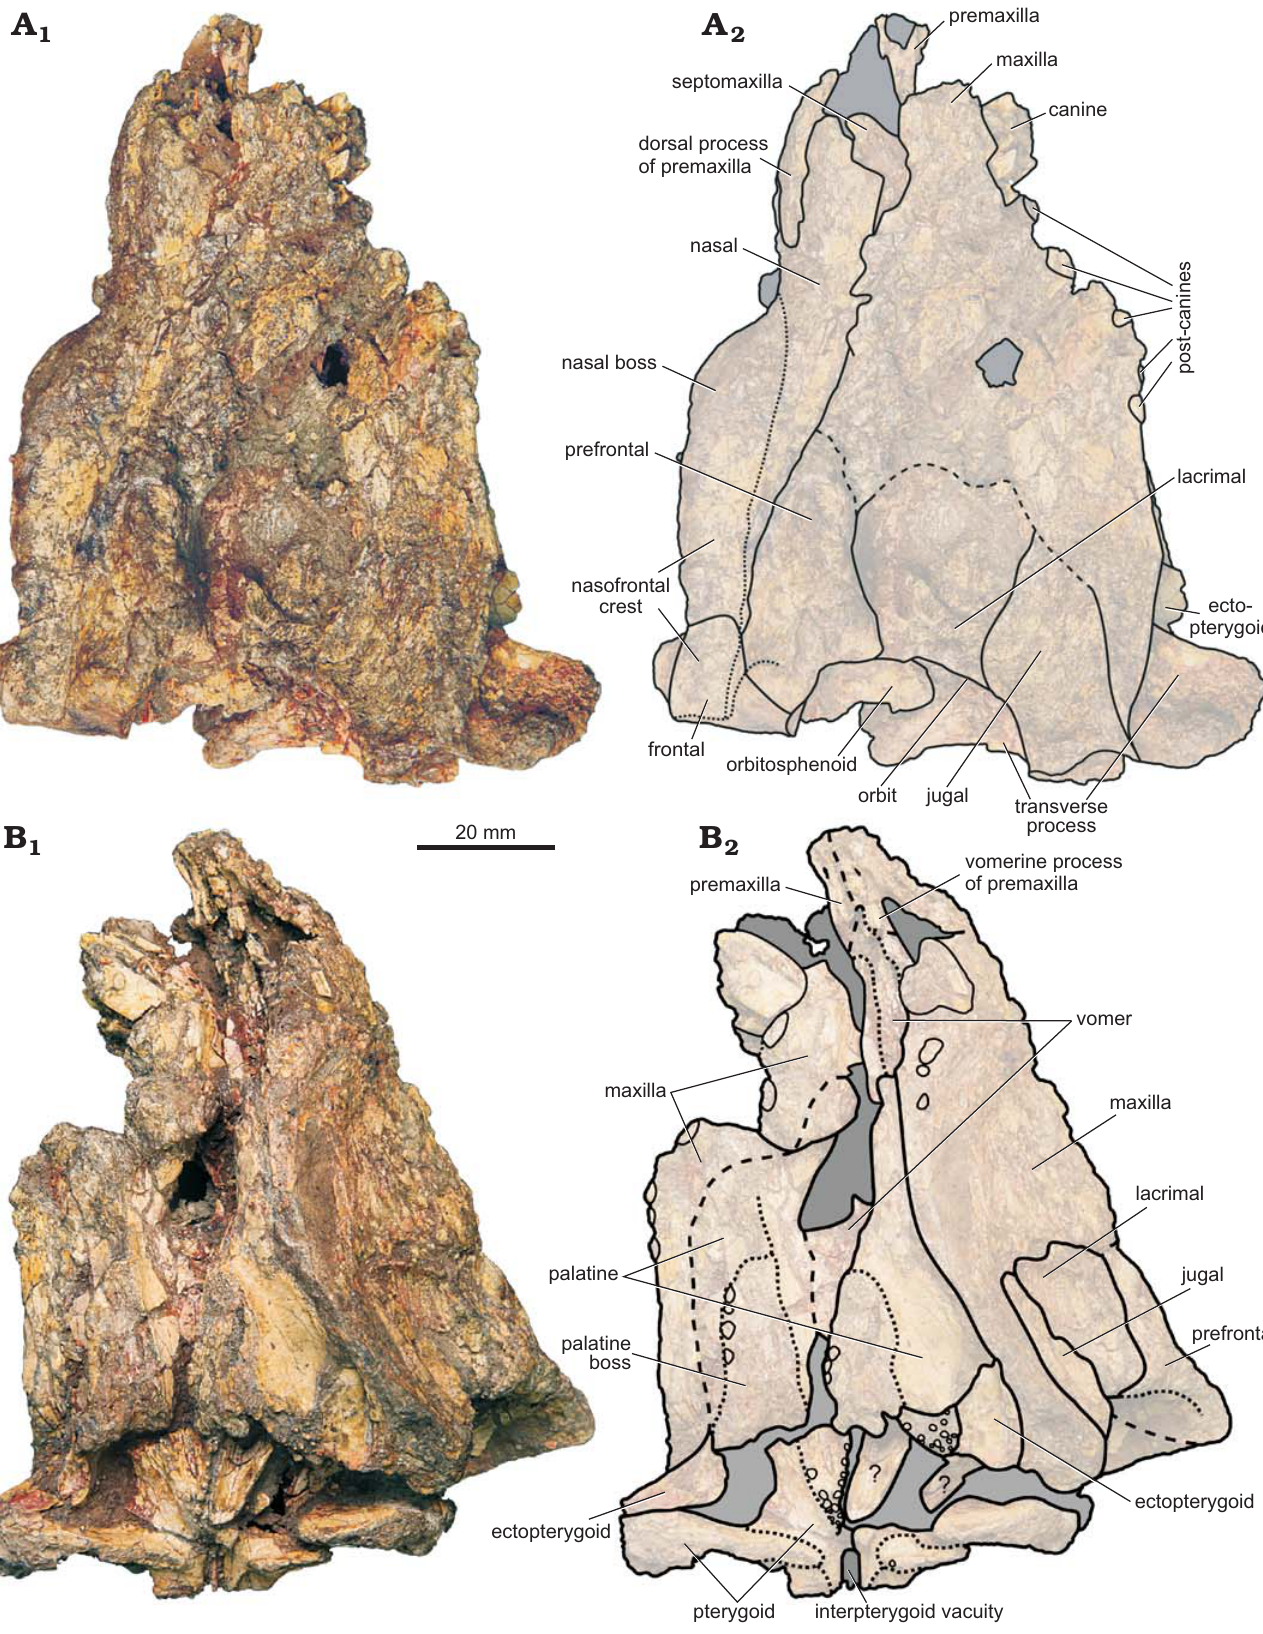
Fig. 4. Burnetiamorpha gen. et sp. indet. (BP/1/7098) from Springfontein, Beaufort West district, South Africa; upper Poortjie Member, Pristerognathus AZ, latest Capitanian; in right lateral ( A ) and ventral ( B ) views. Photographs (A 1 , B 1 ) and explanatory drawings (A 2 , B 2